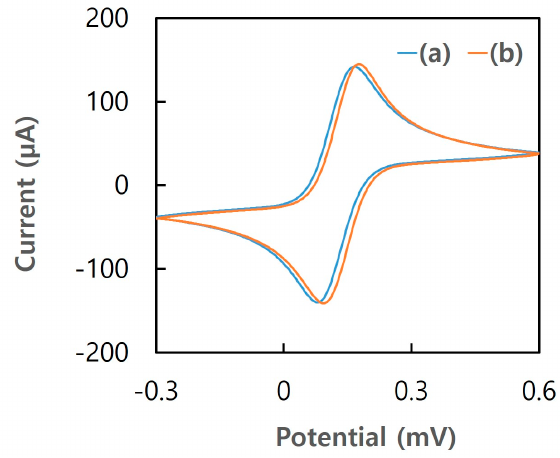
Figure 1. Cyclic voltammograms of electrodes cleaned by ( a ) rinsing with EtOH and ( b ) electrochemical cycling in diluted H 2 SO 4 . A total of 50 µL of 0.1 × PBS (pH 7.4) containing 10 mM Fe(CN) 63 − /4 − and 0.1 M KCl was applied to the electrodes and CV measurements were carried out.